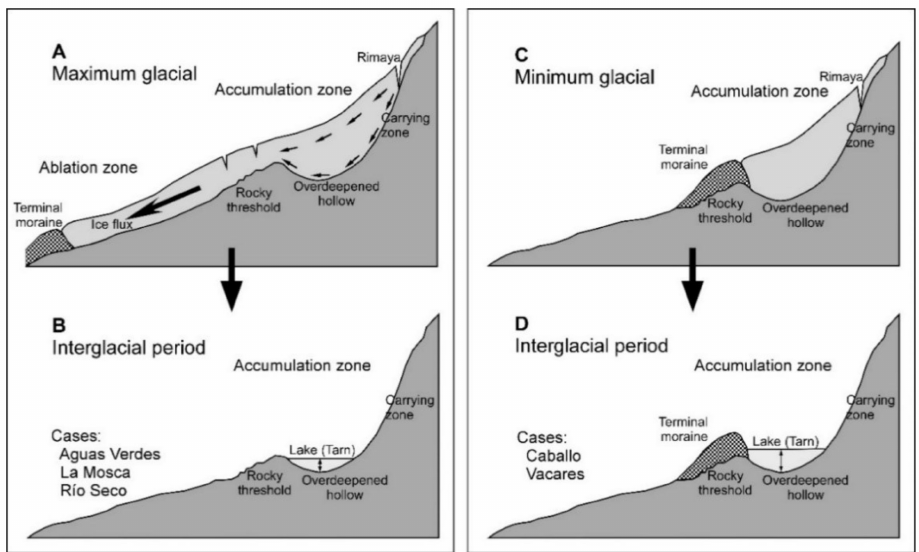
Figure 10. Diagrams of glaciers associated with water-bodies in Sierra Nevada: ( A , B ) evolution of a valley glacier from maximum development to present state and ( C , D ) evolution of a cirque glacier developed during an intermediate cold period until the present